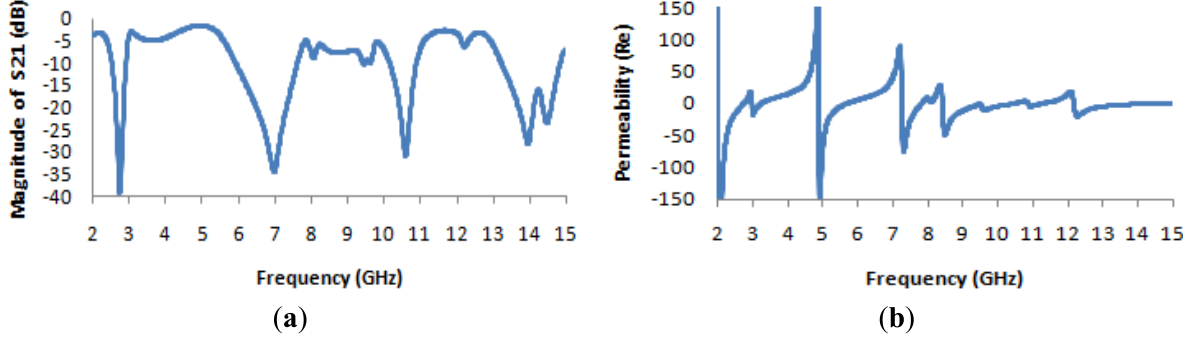
Figure 7. ( a ) The magnitude of the transmission parameter (S 1 × 1 array of the unit structure; ( b ) the real value of permeability vs. frequency for the 1 × 1 array of the unit structure.